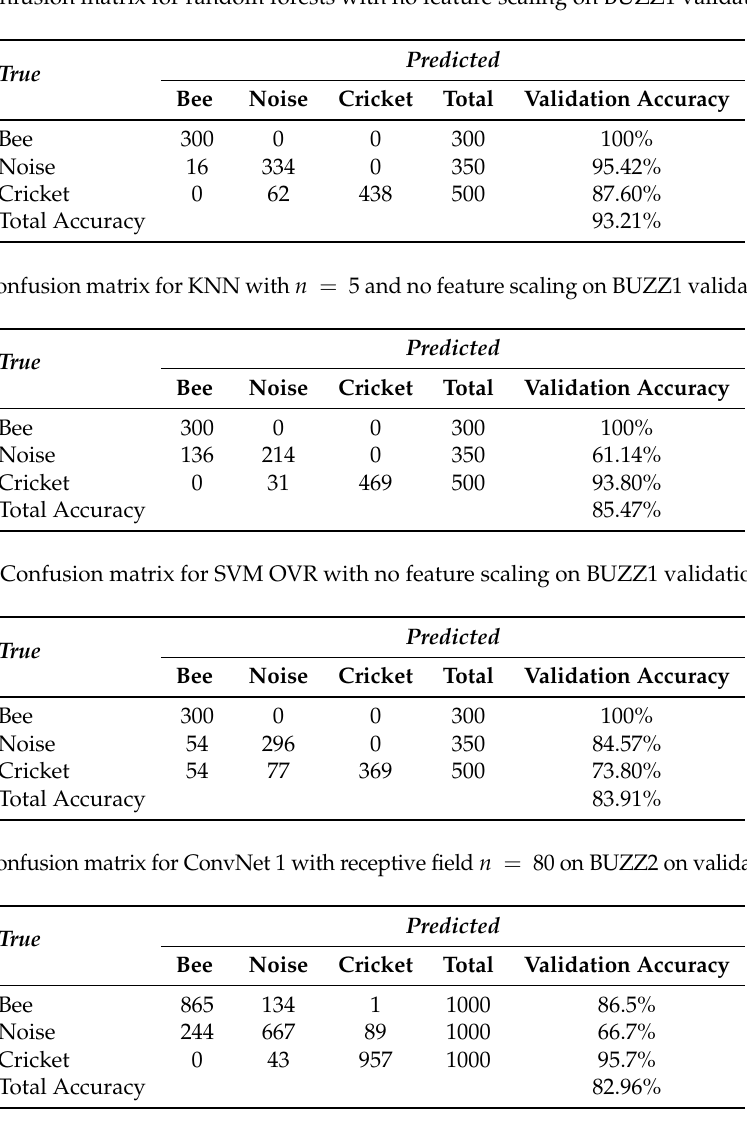
Table A13. Confusion matrix for ConvNet 2 with receptive field n = 80 on BUZZ2 validation